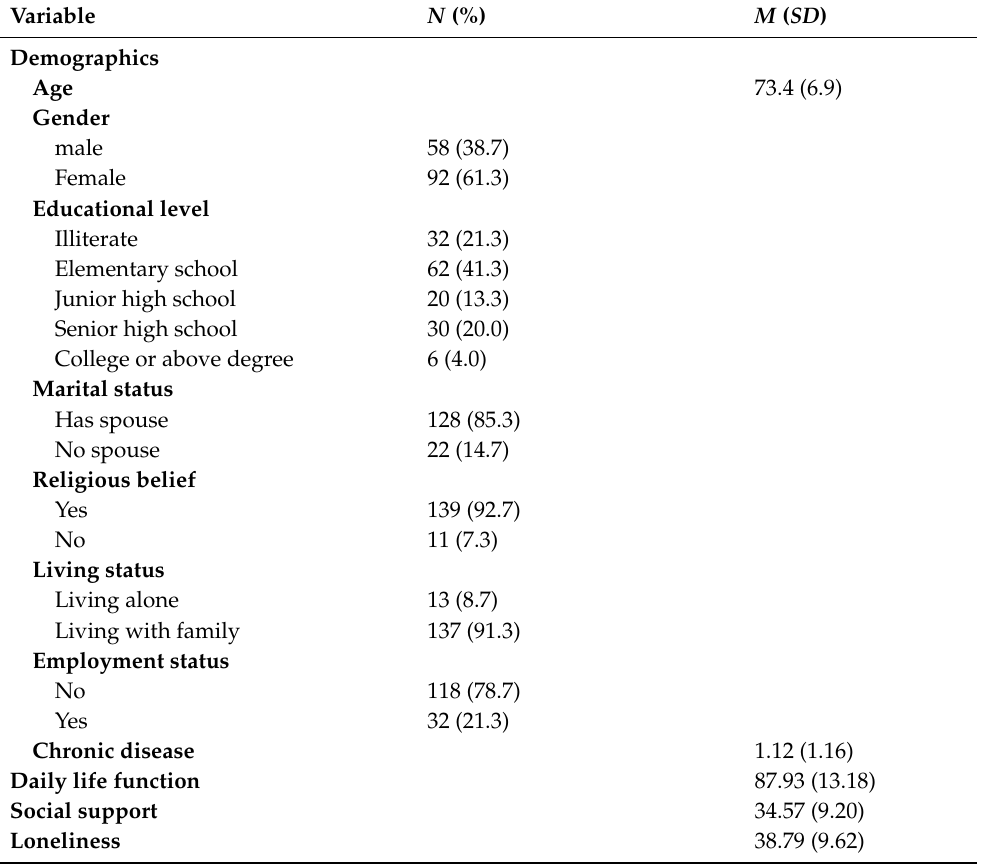
Table 1. Demographic characteristics of the community-dwelling elderly persons ( N =